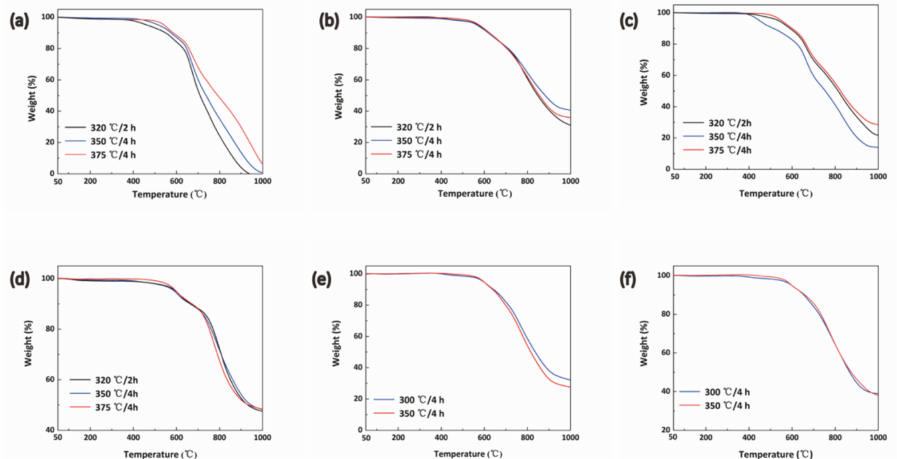
Figure 8. TGA curves of ( a ) BPh-B; ( b ) BPh-Q 5 ; ( c ) BPh-Q 10 ; ( d ) BPh-Q 15 ; ( e ) BPh-Q 20 ; ( f ) BPh-Q 30 in air, the experimental temperature ranges from 50 to 1000 ◦ C, with a heating rate of 10 ◦ C/min (under nitrogen or air atmosphere) and a purge of 40 mL/min. Table 4. Thermal stabilities of BPh-Q and BPh-B treated at different temperatures.